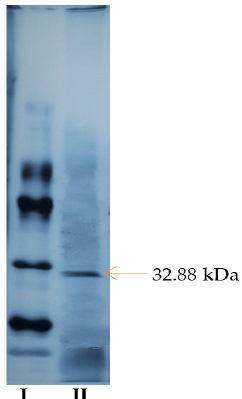
Figure 4. SDS-PAGE electrophoresis gel image of standard proteins ( I ) and purified pectin lyase enzyme from Pseudomonas putida ( II ).